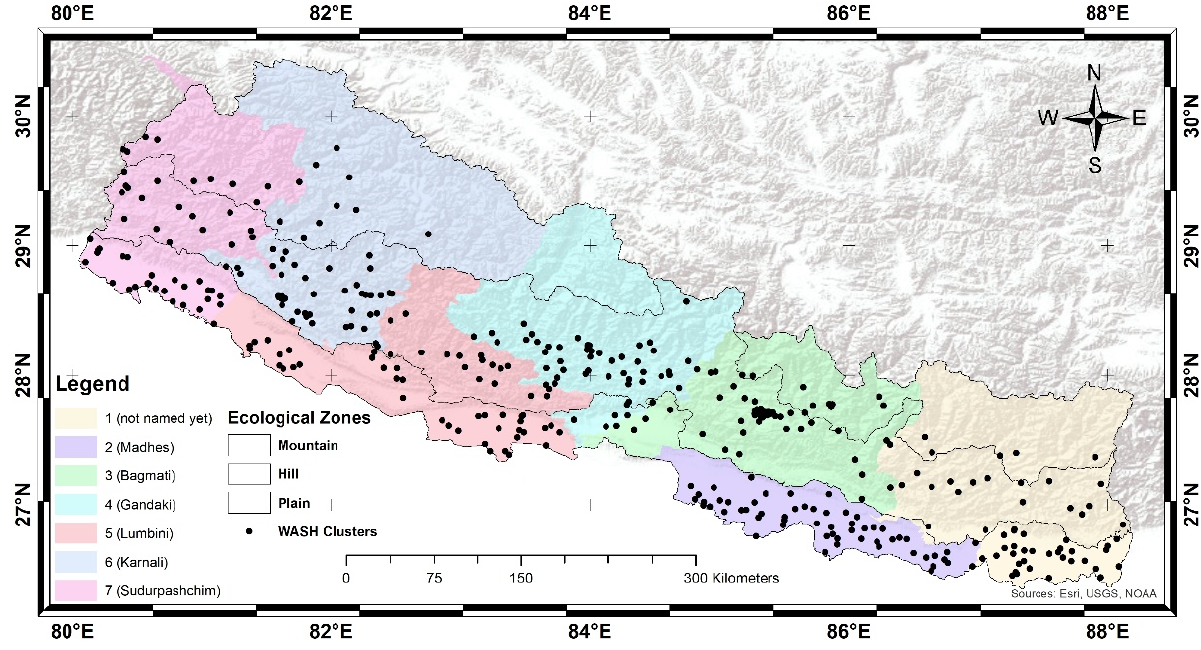
Figure 1. The study area, Nepal, with the province and ecological zones. Each dot represents WASH clusters (ward as a primary sampling unit; n = 363).